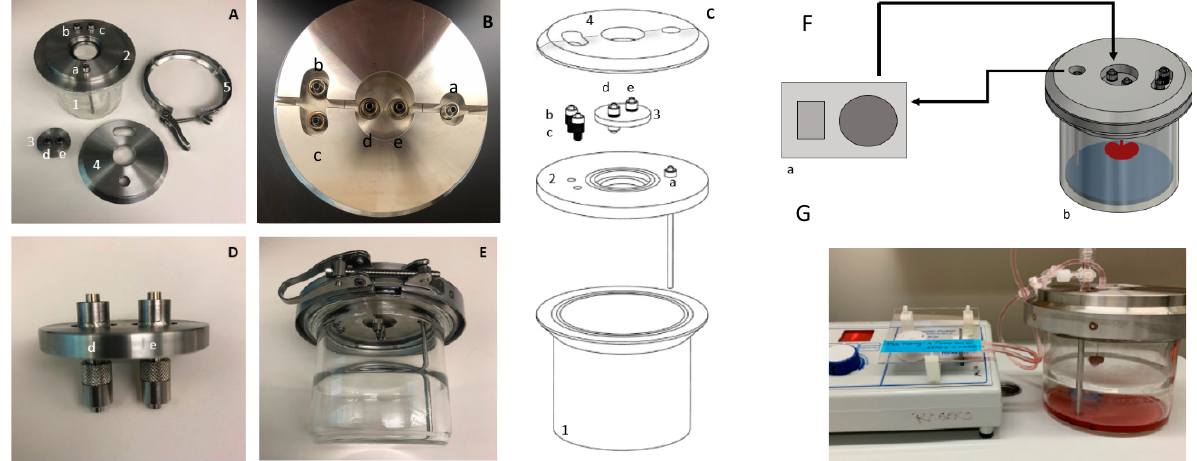
Figure 1. Kidney Bioreactor. Detailed views of the mouse kidney perfusion-bioreactor and individ- ual components ( A ) Unassembled bioreactor with labelled ports: (a) media collection port, (b) ad- justable vacuum port, (c) gauge, (b,c) may be replaced with sterile air filters for chamber ventilation, (d,e) custom swivel male Luer ports for renal artery and ureter cannulas. ( B ) Top view of assembled bioreactor. ( C ) Exploded schematic of bioreactor. (C1) Glass media chamber. (C2) Base lid. (C3) Kid- ney suspension plate. (C4) Alignment plate. ( D ) Magnified image of the kidney suspension plat- form. The suspension platform has two regular male luer locks on the top side and two custom swivel male Luer locks below. ( E ) Interior view of the full assembly. ( F ) Diagram of perfusion circuit setup. ( G ) Perfusion circuit setup with a singular adult mouse kidney .